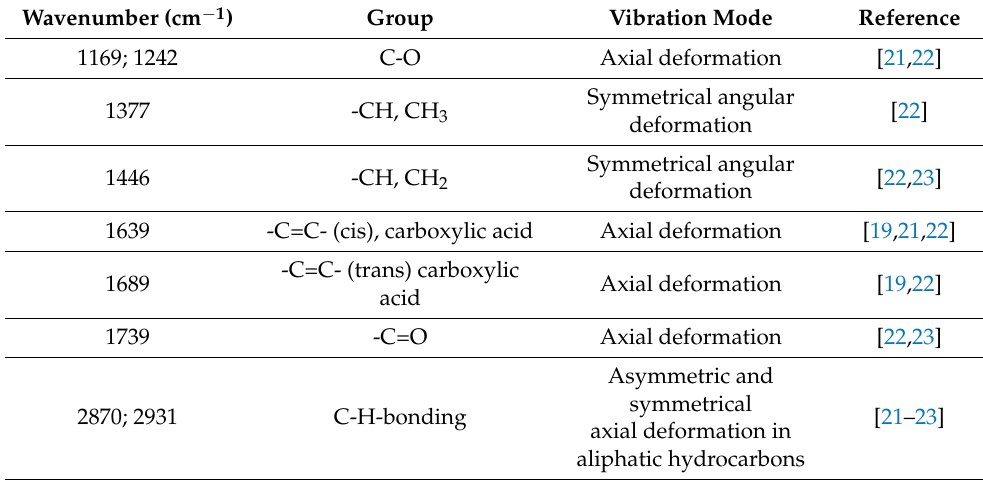
Table 2. FTIR-PAS assignment of COR, relative to Figure 1.